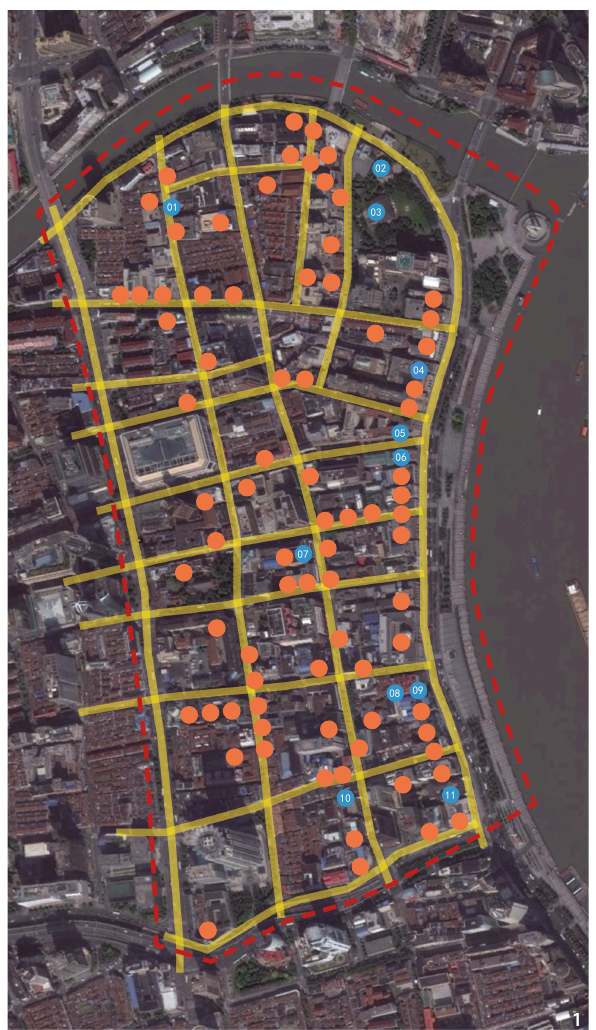
Figure 1 The Bund area of Shanghai and the location of the studied buildings. The blue dots showed the buildings which were discussed in the paper. (Source: the